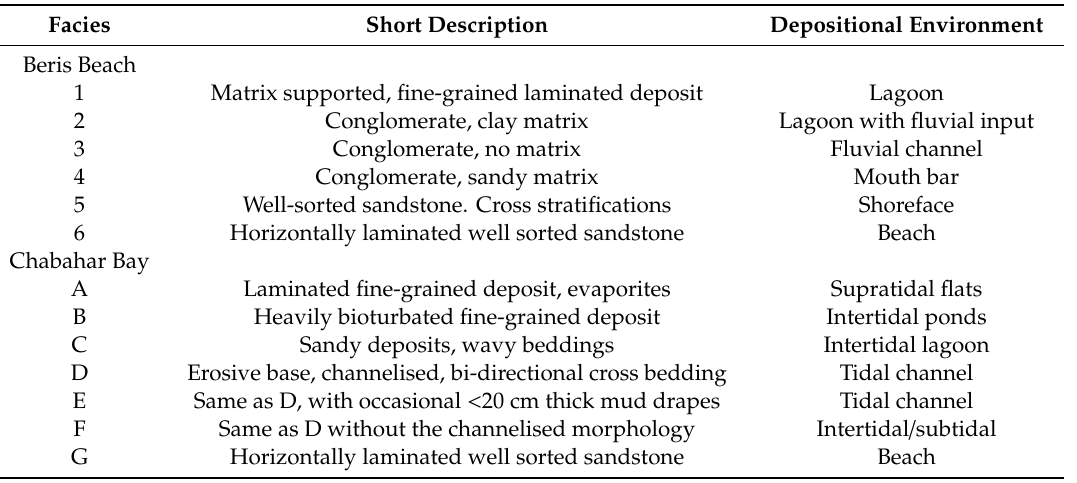
Table 3. Short description and interpretation of the facies of Beris and Chabahar Bay cross sections. More details may be found in Supplementary Table